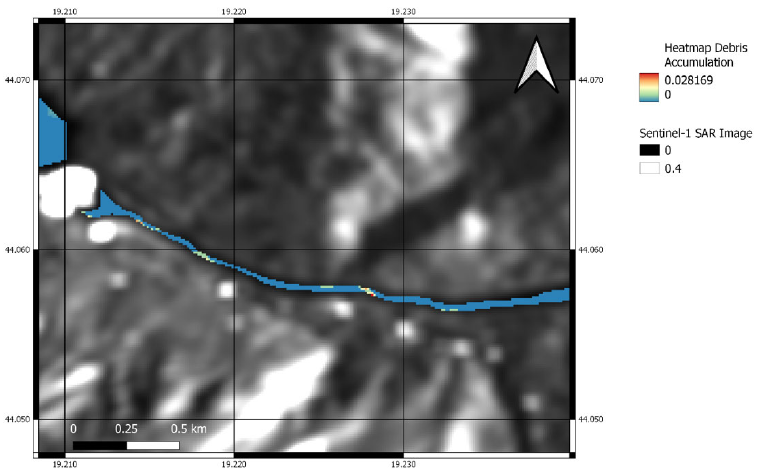
Figure 18. Heatmap of Drina River system after Bajina Basta hydroelectric dam near Peru´cac, Serbia, from 5 January 2019 to 26 December 2021 (total 142 acquisitions). Basemap: multitemporal average of Sentinel-1 VV images. Colour: heatmap. (Sentinel-1, Credits: